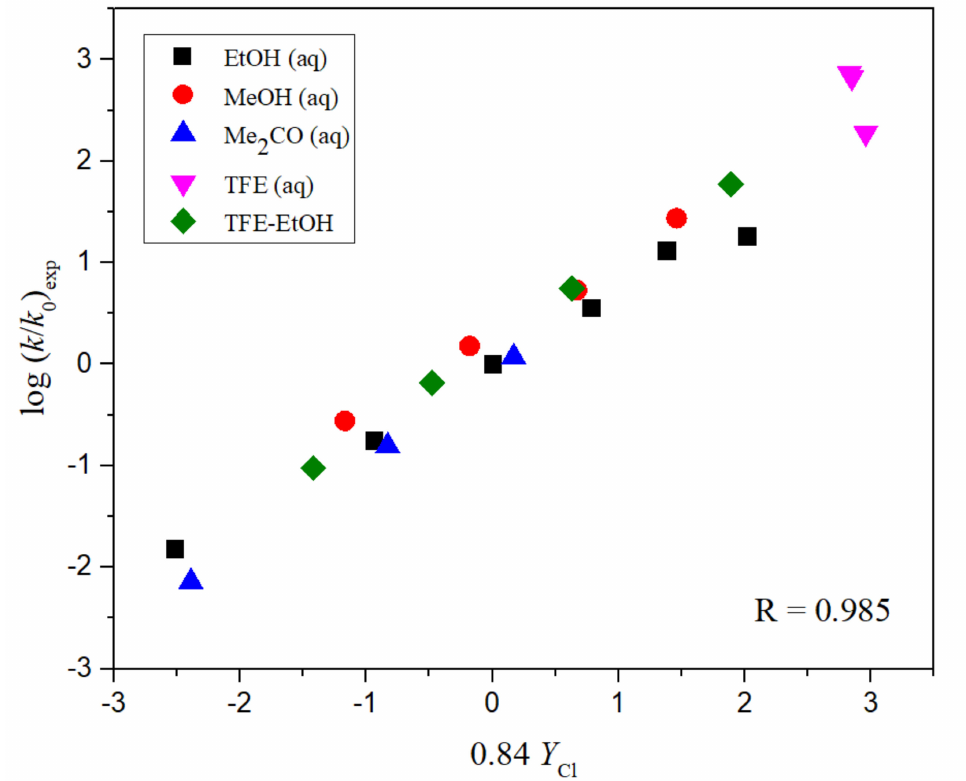
Figure 1. The plot of log ( k / k o ) exp for 1-adamantyl chlorothioformate ( 1 ) against Y Cl in all of the 20 solvents at 25.0 ◦ C. Y Cl is the solvent ionizing power, R is correlation